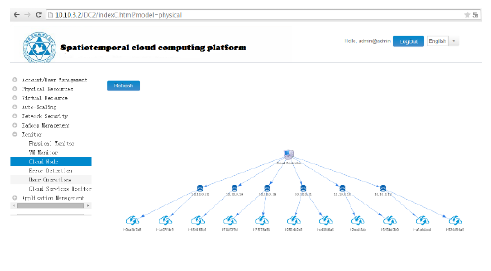
Figure 5.1. Cloud nodes